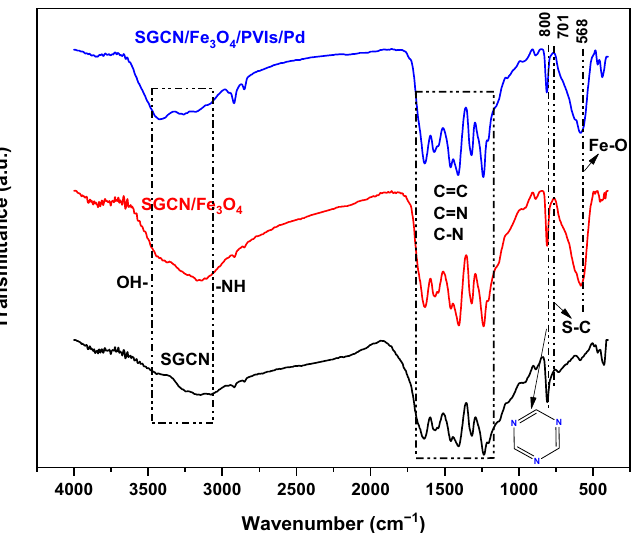
Figure 3. FT-IR spectra of SGCN, SGCN/Fe 3 O 4 and SGCN/Fe 3 O 4 /PVIs/Pd